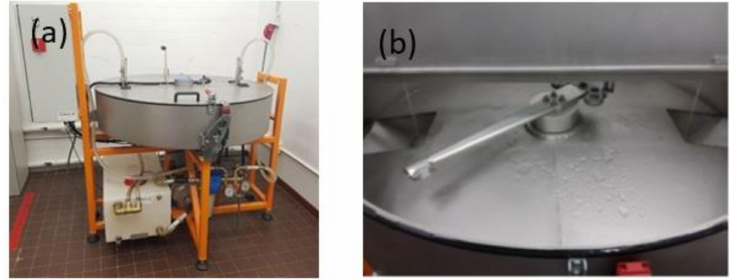
Figure 1. ( a ) Jet erosion equipment; ( b ) Detail of the rotating arm, where the sample is fixed. To benchmark the wear behavior of CGS and HVOF coatings, the behavior of 316L and carbon steel bulk materials was also evaluated carrying out rubber wheel, ball-on-disk, and jet erosion